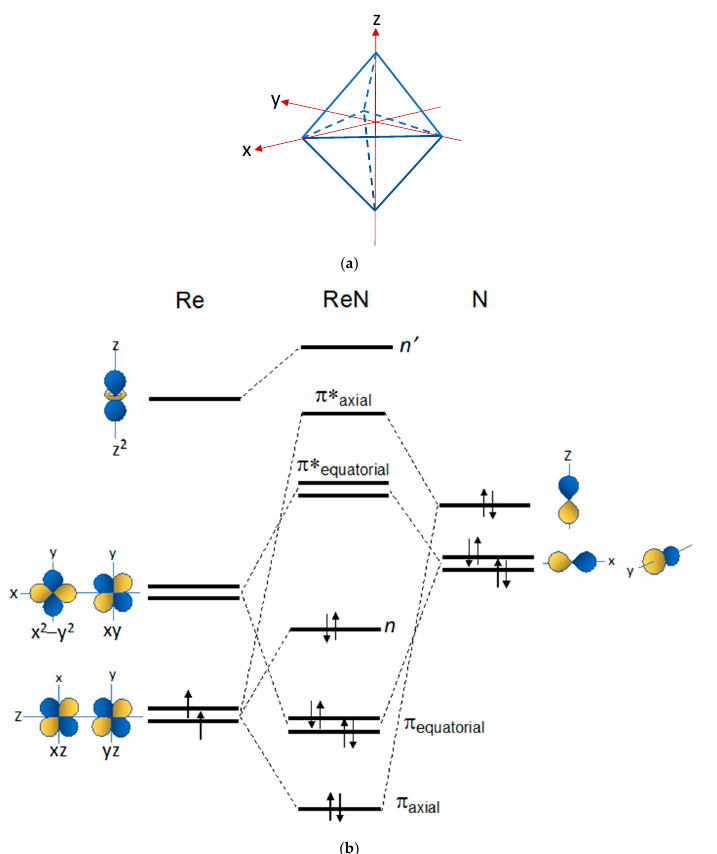
Figure 5. ( a ) Trigonal-bipyramidal geometry ( tbp ). In this geometry, the rhenium atom lies at the centre of the equatorial trigonal plane and the heteroatom (N) spans one vertex on the same plane. ( b ) Qualitative energy level diagram of frontier molecular orbitals (FOs) for the [Re ≡ N] 2+ group in a tbp geometry (energy is reported on the vertical y-axis). In the Figure, n and n’ are non-bonding FOs. Molecules 2023 , 28 , x FOR PEER REVIEW